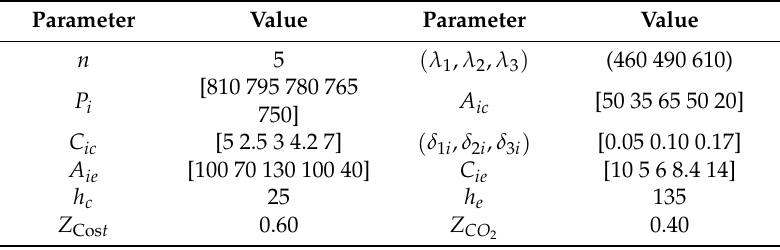
Table 1. Data for numerical